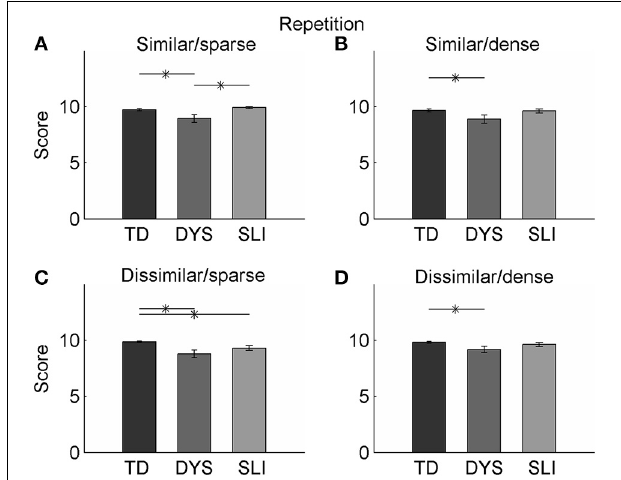
FIGURE 1 | Performance on the repetition portion of the task. (A) DYS children performed worse than both TD and SLI children on the repetition portion of the task when words were from sparse neighborhoods and when the words were similar sounding. (B) All groups performed similarly on the task when words were from dense neighborhoods and were similar sounding, though the DYS group’s performance was significantly below the TD group. (C) TD children performed better than both DYS and SLI children when words were from sparse neighborhoods and were dissimilar sounding. (D) All groups performed similarly on the task when words were from dense neighborhoods and were dissimilar sounding, though the DYS group’s performance was significantly below the TD